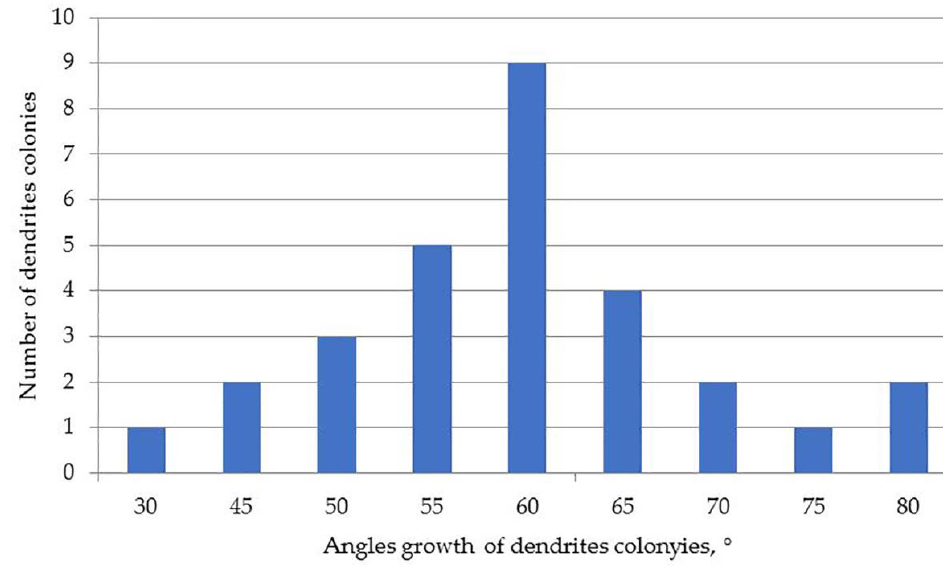
Figure 8. Distribution of dendritic colonies growth